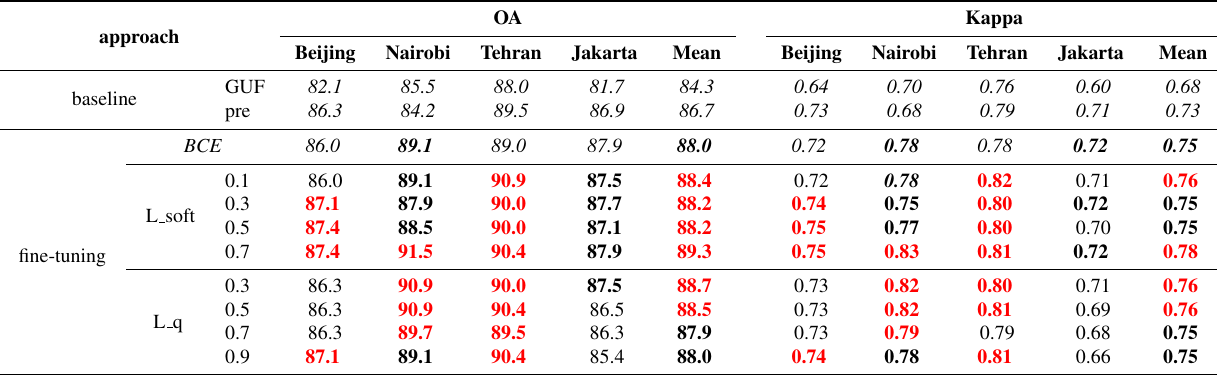
Table 1. OA and Kappa values for different approaches in the four test cities. Boldface indicates there is an improvement over results from pre-trained classifiers (Pre), and red color indicates an improvement over the default fine-tuning approach (BCE).